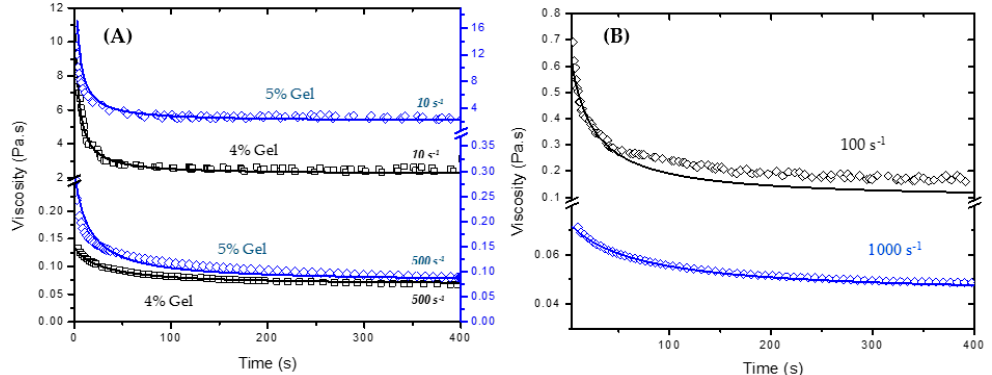
Figure 7. ( A ) Experimental (symbols) and predicted viscosity (lines) data for 4% and 5% gels at 10 and 500 s − 1 . The 4% data is plotted in the left Y -axis and is represented by square symbols. The 5% data is plotted in the right Y-axis and is represented by diamond symbols; ( B ) calculated viscosity assuming λ e = 1 for 4% gels at shear rates of 100 and 1000 s − 1